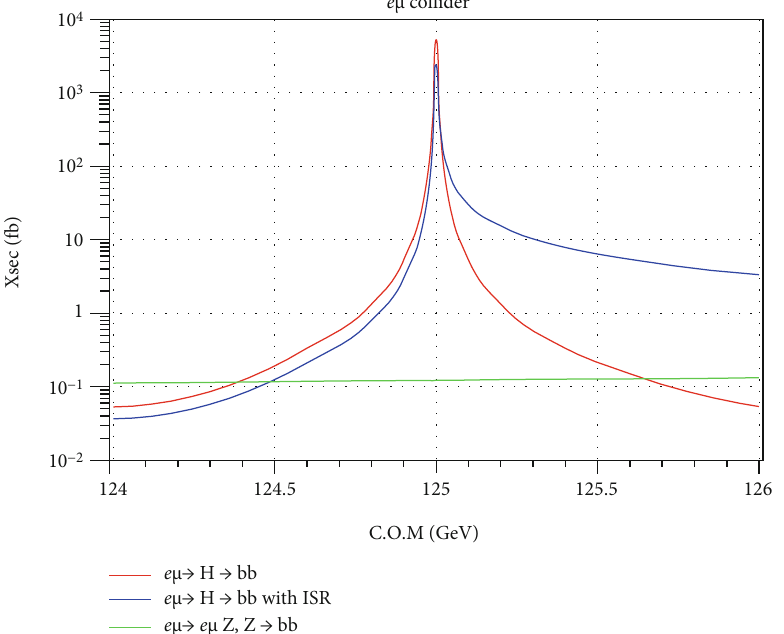
ffiffi p = 125 GeV for Higgs CLFV production e μ ⟶ H ⟶ b (cid:2) b and the dominant background e μ ⟶ νν Z ⟶ νν b (cid:2) b Figure 2: Energy scan near s ∣ is set by default to match the current limit on Br( H ⟶ e μ ) from ATLAS at an electron-muon collider. The CLFV Yukawa couplings ∣ Y e μ experiment